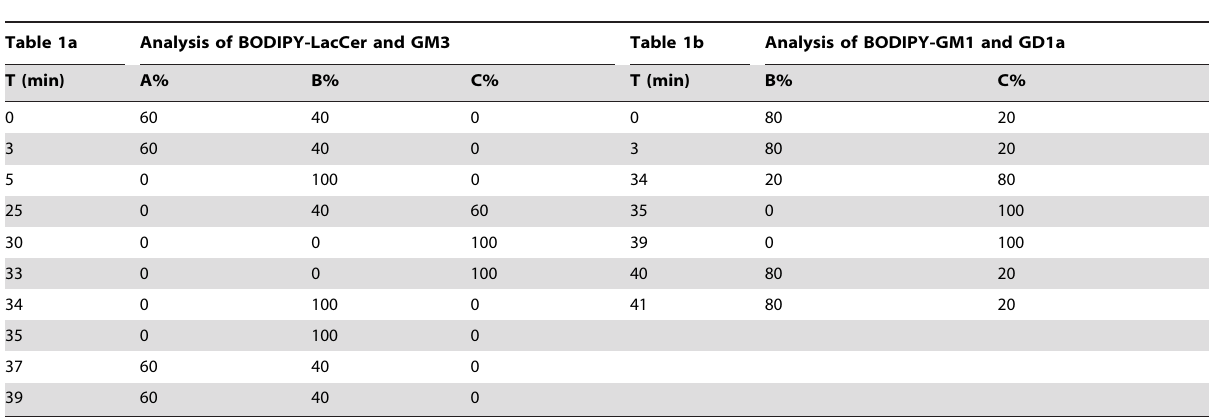
Table 1. HPLC gradient elution programs for the analysis of BODIPY gangliosides.